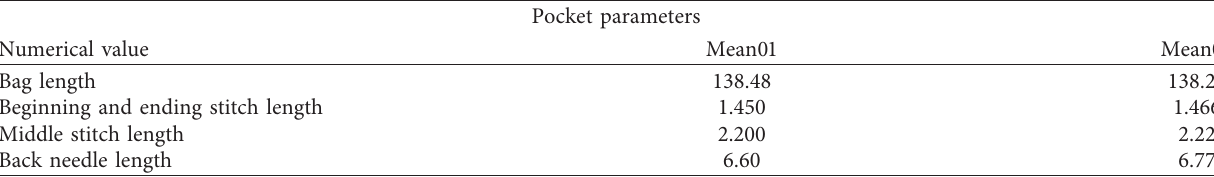
Table 4: 01 and 02 fabric experimental